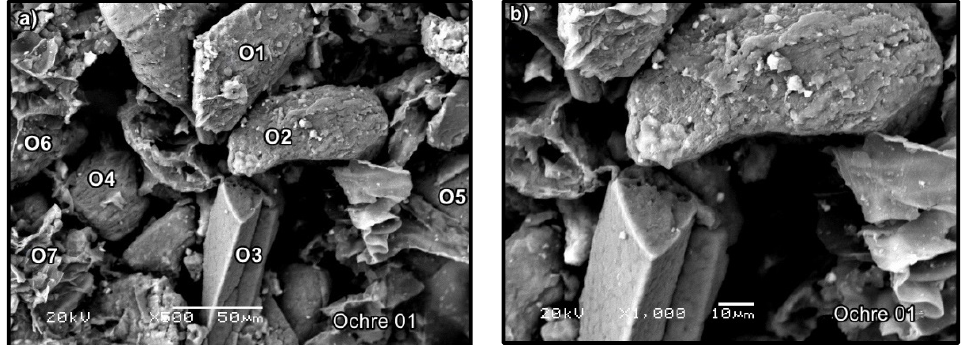
Figure 6. Micrograph of the ochre pigment marking the main classes of morphology: ( a ) sample 01, and ( b ) magnification of an area of sample 01. Table 4. Elemental composition (wt%) determined through EDS of the Ochre samples.